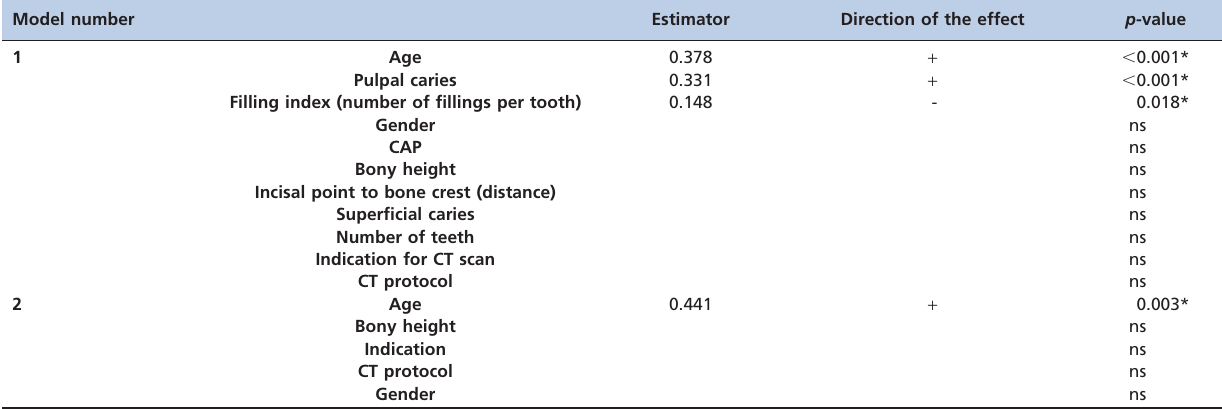
Table 2 - Linear regression analyses of different factors influencing the atherosclerotic burden. First model: all patients. Second model: Edentulous patients. N= 292 (first model) and n = 44 (second model). The R 2 values for the first and second models were 0.276 and 0.194,